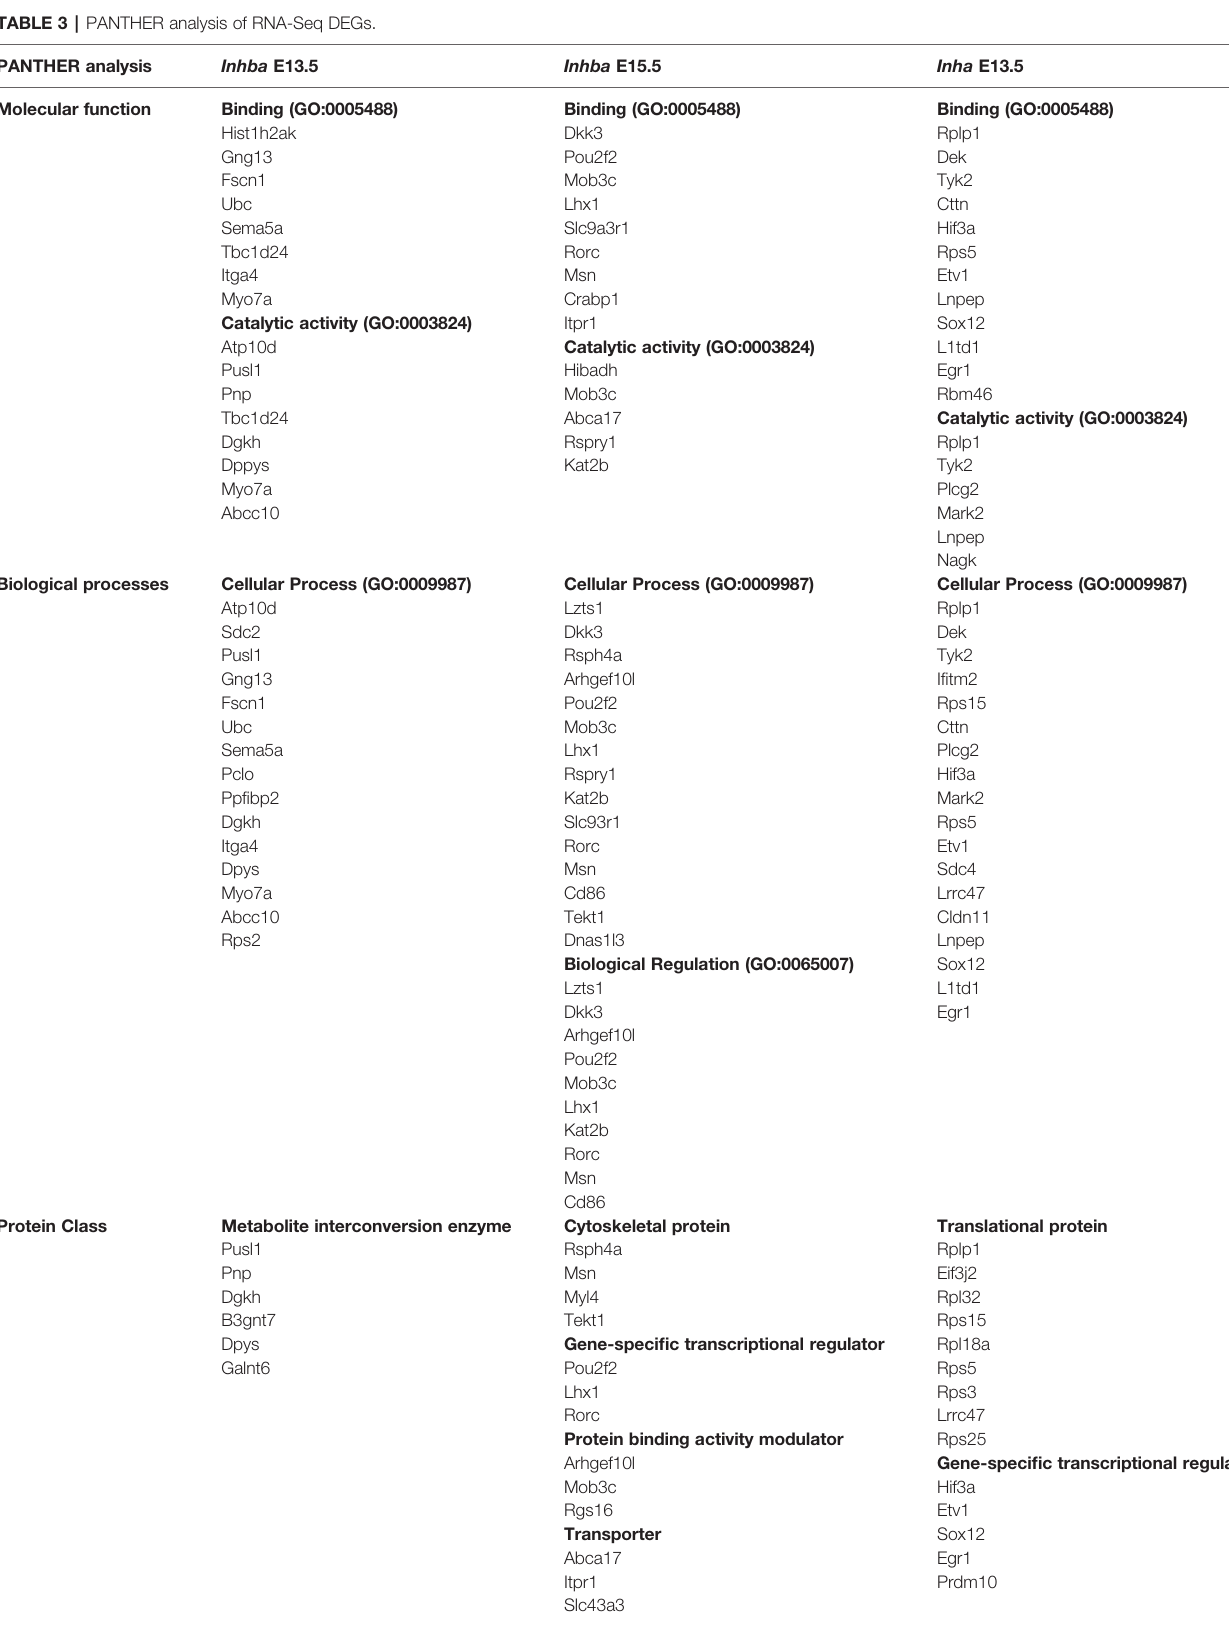
TABLE 3 | PANTHER analysis of RNA-Seq